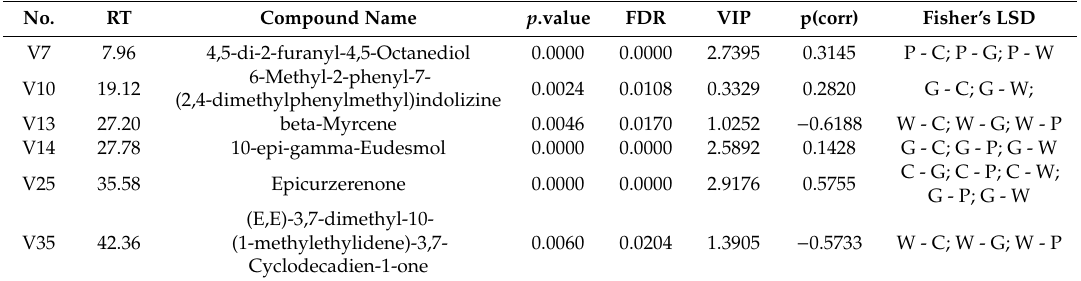
Table 1. Discriminatory components of the crude and the processed Curcuma